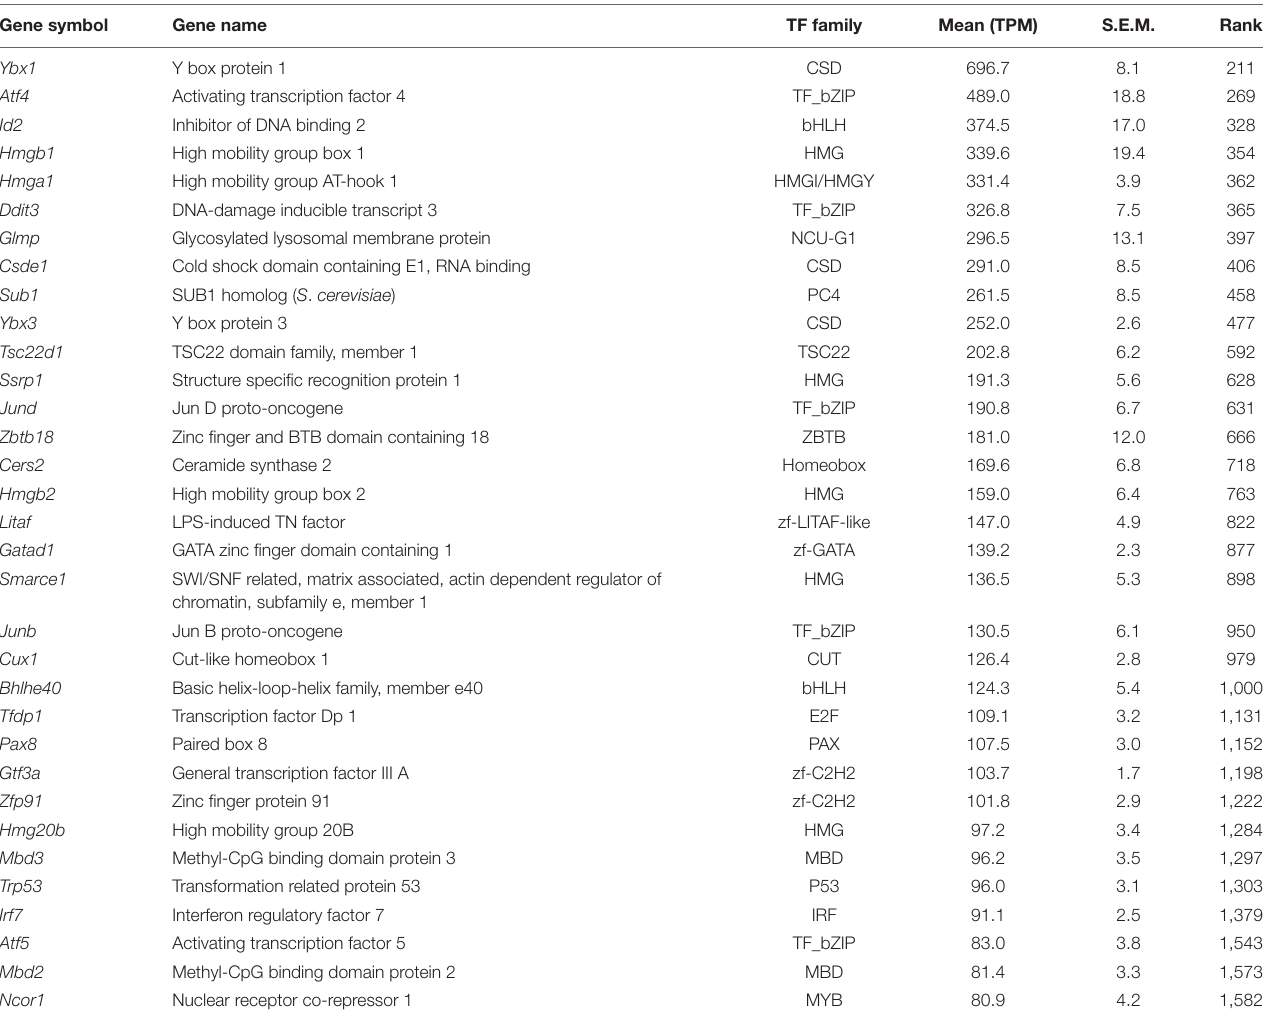
TABLE 1 | Top 30 transcription factors (see the full transcription factor list in Supplementary Table 1